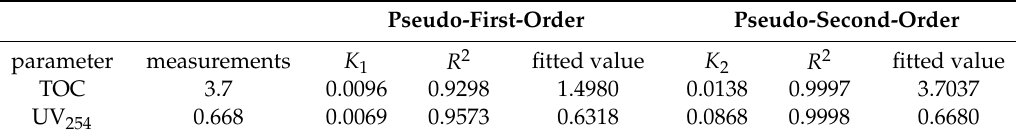
Table 4. Kinetic parameter fittings using the pseudo-first-order kinetic model and pseudo-second-order kinetic models.